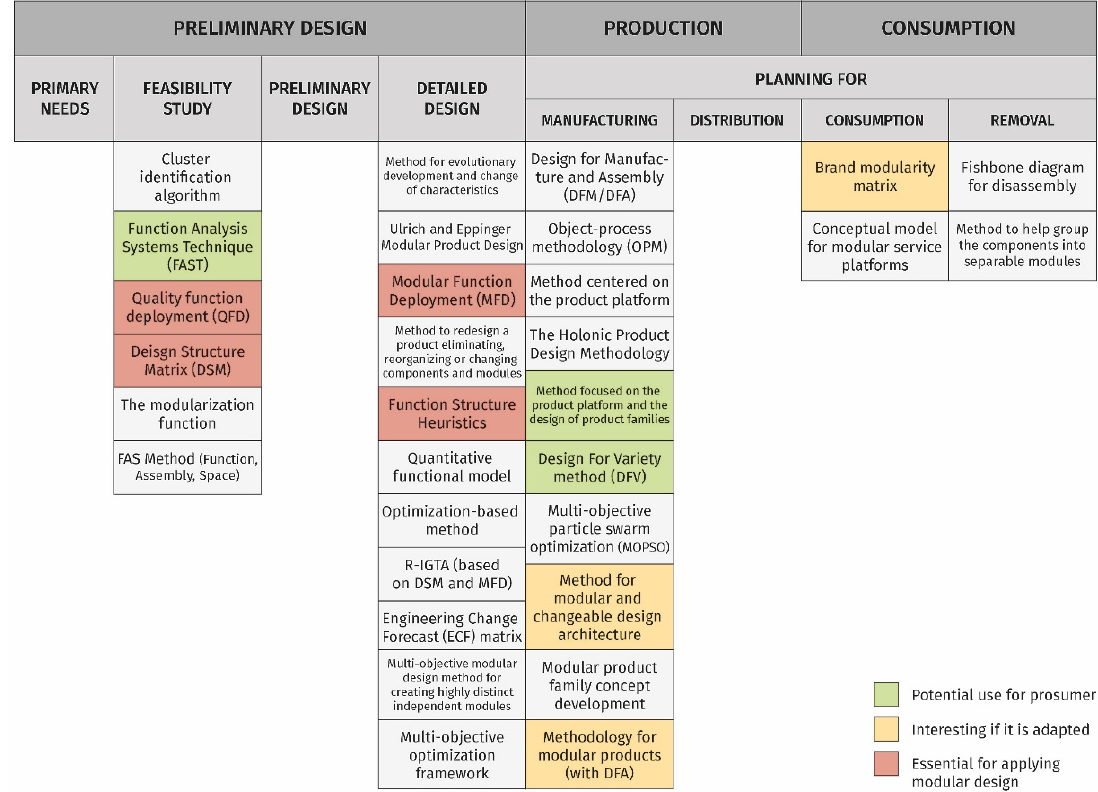
Figure 2. Analysis of current modular design methods according to the phases of the process.